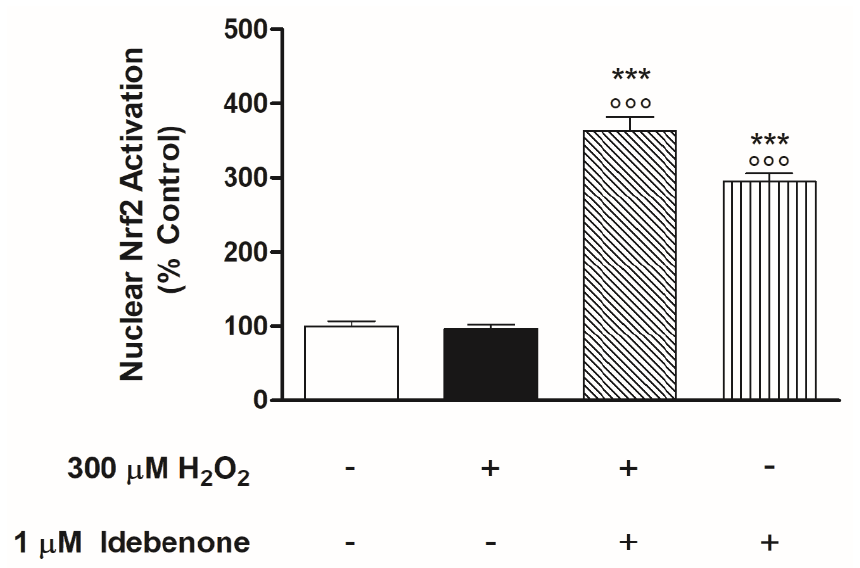
Figure 2. Idebenone stimulates Nrf2 nuclear translocation in ARPE-19 cells. Idebenone significantly increased NRF2 nuclear activation in both basal and 300 µ M H 2 O 2 stimulated conditions. All of the optical density values (see Materials and Methods) are expressed as a percentage relative to the non-treated cells (control 100%) ± SEM of three independent experiments performed in triplicate (nine in all, for each experimental group). *** p < 0.001 vs. control; ◦◦◦ p < 0.001 vs. H 2 O 2 alone. The switching on and off of Nrf2 protects cells from oxidative/apoptotic damage induced by endogenous and exogenous harmful factors by transcriptional activation of genes that control cellular homeostasis. Our study focused on NRF2-mediated IDB anti- apoptotic effects, particularly those under direct mitochondrial control. Consequently, we conducted experiments to verify whether IDB modulated the intracellular levels of two antagonist proteins of the Bcl-2 family, Bax and Bcl-2. We observed high intracellular levels of Bax and low levels of Bcl-2 (the values are superimposable with those of the untreated control) after exposition to oxidative stress alone (Figure 3). Pre-treatment (24 h) with 1 µ M IDB significantly increased both basal and stimulated Bcl-2 levels, while antagonizing those of Bax, in the presence of H 2 O 2 ; IDB did not change baseline Bax levels (Figure